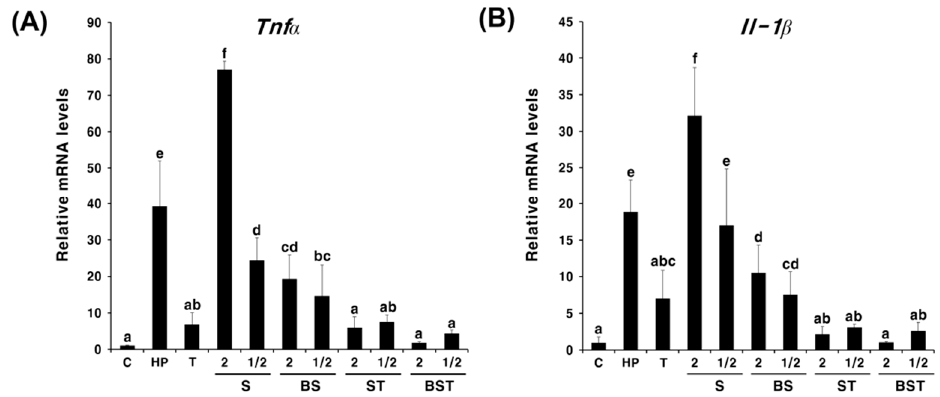
Figure 3. Expression levels of Tnf α ( A ) and Il-1 β mRNA ( B ) in the pylorus tissue of Helicobacter pylori -infected and control mice administered different concentrations of solar and bamboo. Different letters indicate a significant difference ( p < 0.05) ascertained via the Turkey-Kramer test. C, control group (uninfected); HP, infected group (negative control); T, triple therapy treatment group (positive control); S, solar salt treatment group; BS, bamboo salt treatment group; ST, solar salt + triple therapy treatment group; BST, bamboo salt + triple therapy treatment group. 2, Double of the recommended daily intake of salt; 1/2, half of the recommended daily intake of salt. Triple therapy-treated groups were administered the same dose of triple